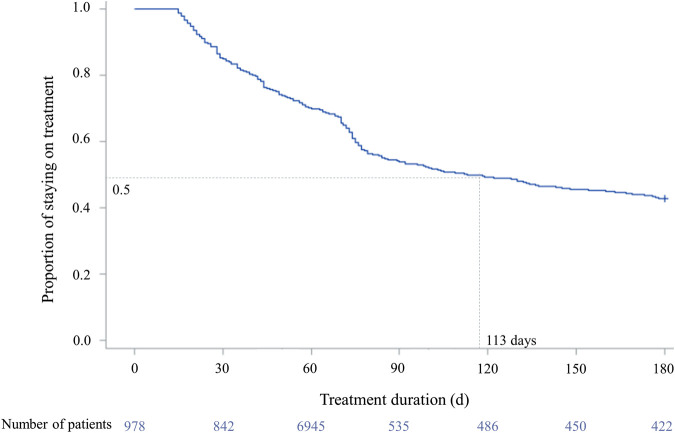
Time-to-discontinuation of tuberculosis drug in study population. †Drug-susceptible tuberculosis treatment was defined as discontinued if the prescription gap was over 14 days. ‡The median time-to-discontinuation: 113 days (interquartile range 96–136). ¶Log-rank test: p < 0.0001.